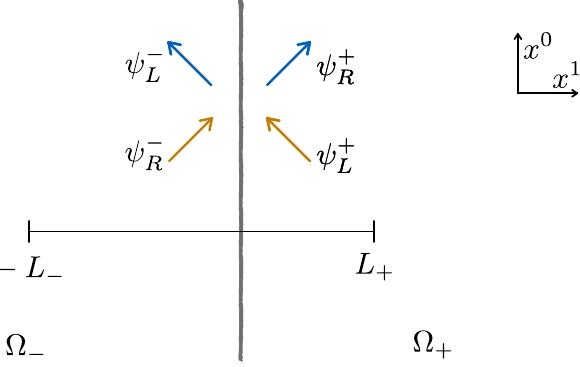
Figure 1: Setup for the fermion problem with a semitransparent interface. The in- “ 0, and the regions x terface or defect is located at x 1 “ 0 the fermion fields are related by the S -matrix by Ω and Ω , respectively. At x ´ ` 1 in (2.5). For the entanglement computation we consider an interval r´ L “ straddles the defect at x 1